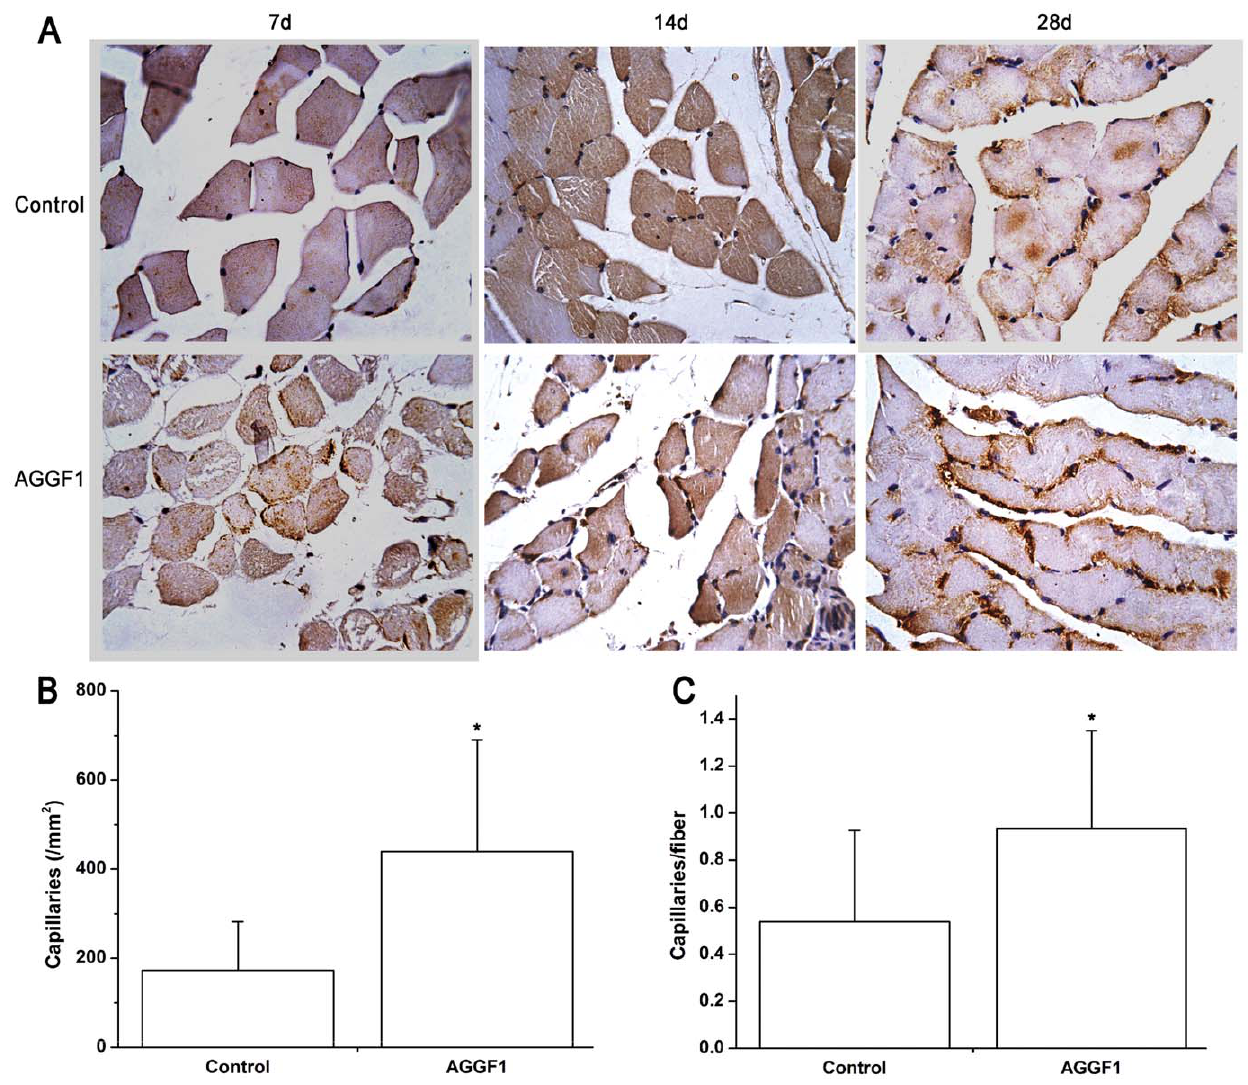
Figure 5. Overexpression of human AGGF1 stimulated angiogenesis in a mouse hindlimb ischemia model. A ) Representative images of sections of ischemic hindlimb muscles immunostained with an anti-CD31 antibody 7, 14, or 28 days after injection of AGGF1 plasmid DNA or empty vector DNA (control). B ) Quantification of density of CD-31-positive vessels per mm 2 in ischemic muscles 28 days after injection of DNA. C ) The number of CD-31-positive vessels per muscular fiber 28 days after injection of DNA. *, P ,